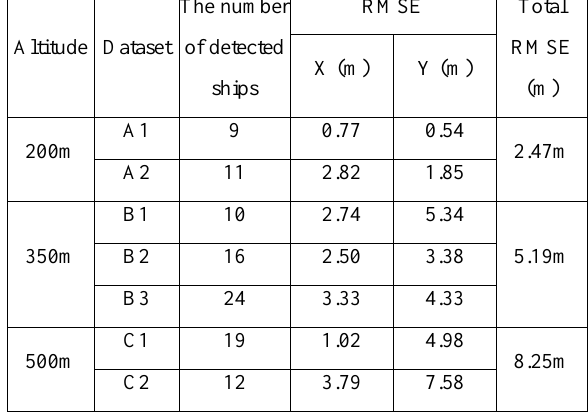
Table 11. Ship location accuracy in Tongyeong